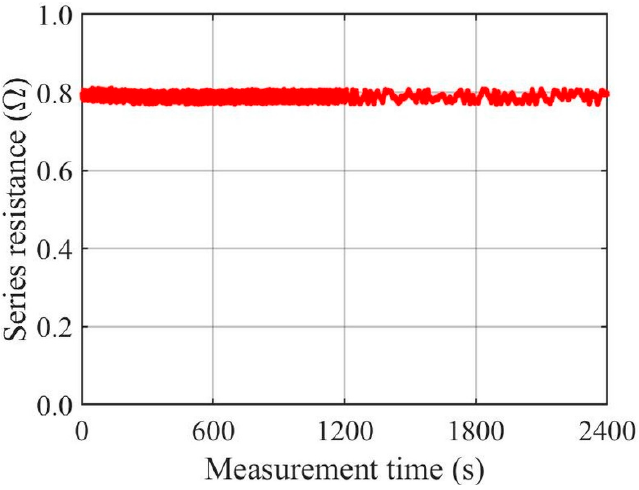
Figure 6. Fitted photocurrent values during the 40 min measurement period converted to STCs as a function of the cutting limit based on MPP power.